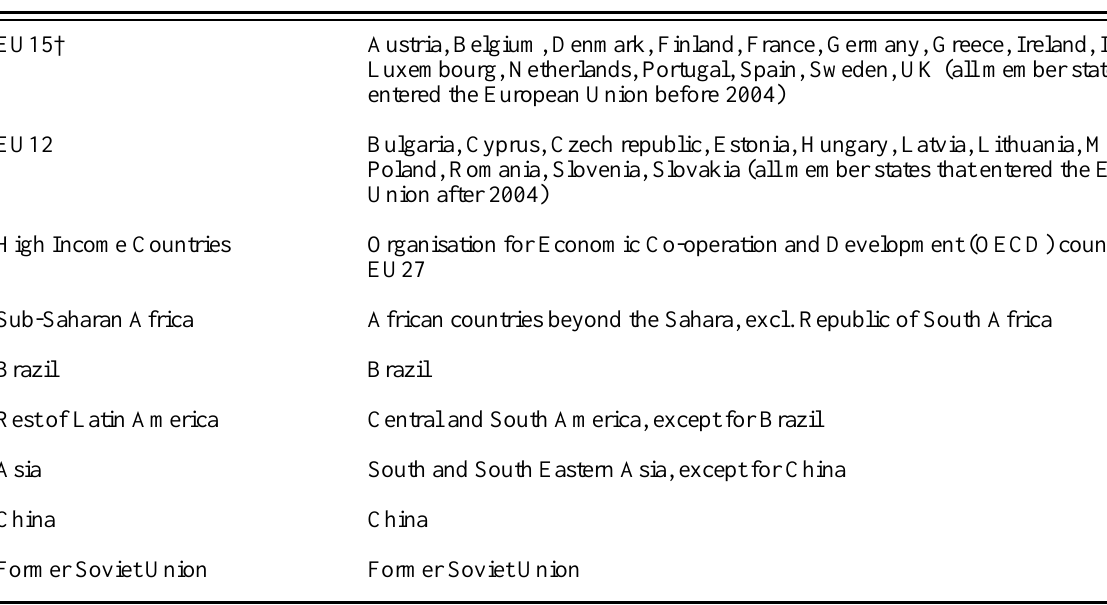
Table 2 . Definitions of aggregated